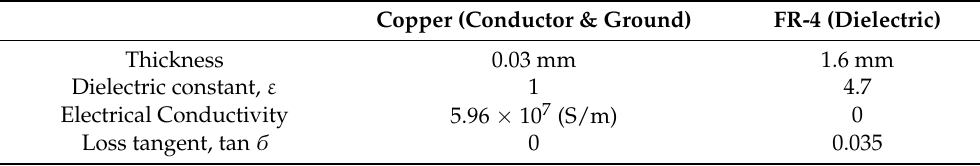
Figure 1. Full dimension of a patch antenna for 2.45 GHz frequency. Table 1. Properties of conductor and dielectric of microstrip patch